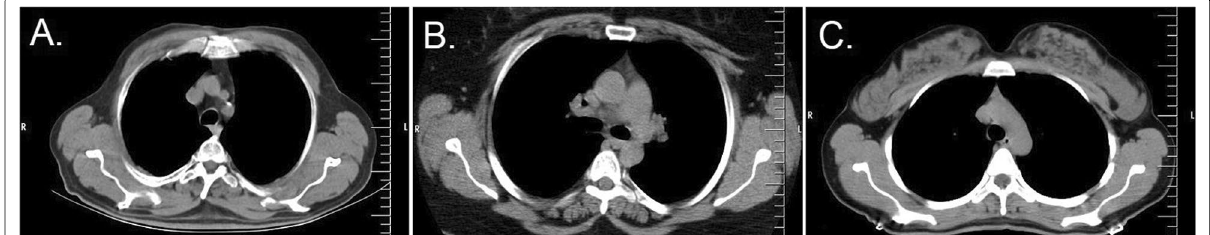
Fig. 4 Homogeneous fat; which was entirely fat infiltration to anterior mediastinum ( A ), reticular type; fatty infiltration of thymus containing < 50% thymus tissue without well-defined contours ( B ) and nodular type; which had < 50% fat infiltration with well-defined contours ( C )